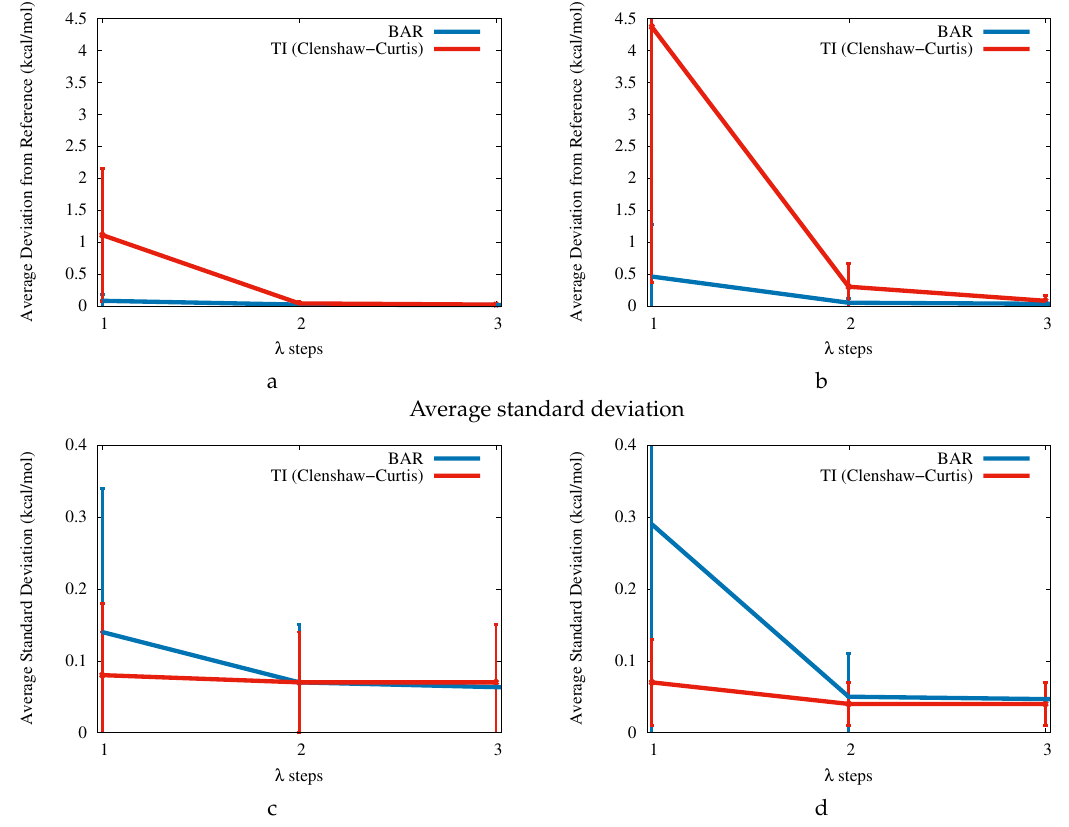
Figure A1. Convergence of the free energy of uncharging ( ∆ G char ) with respect to the number of λ steps. ( a ) Average deviation from reference results for all twelve molecules using the fixed charge force field. ( b ) Average deviation from reference results using the Drude force field. ( c ) Average standard deviation using the fixed charge force field. ( d ) Average standard deviation using the Drude force